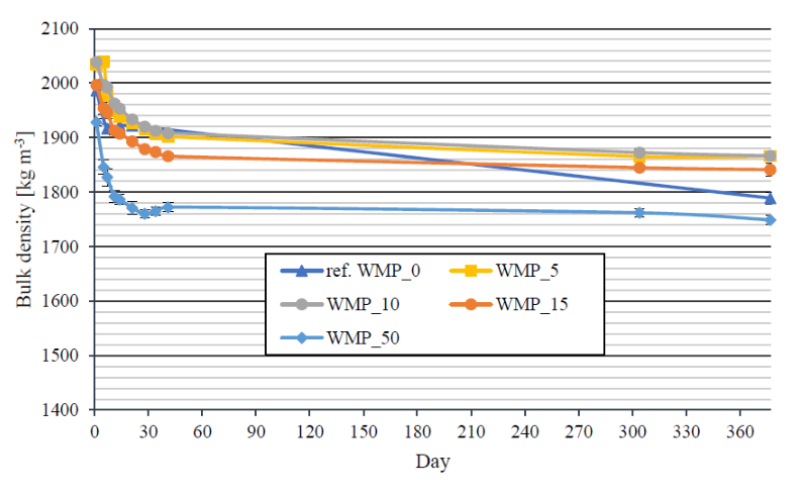
Figure 2. Time dependence of Bulk density (with standard deviation).